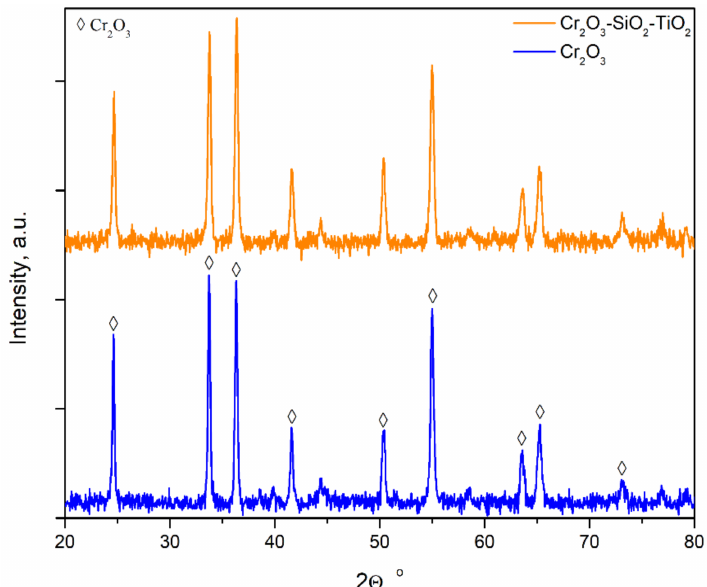
Figure 2. The XRD patterns of the Cr 2 O 3 and Cr 2 O 3 -SiO 2 -TiO 2